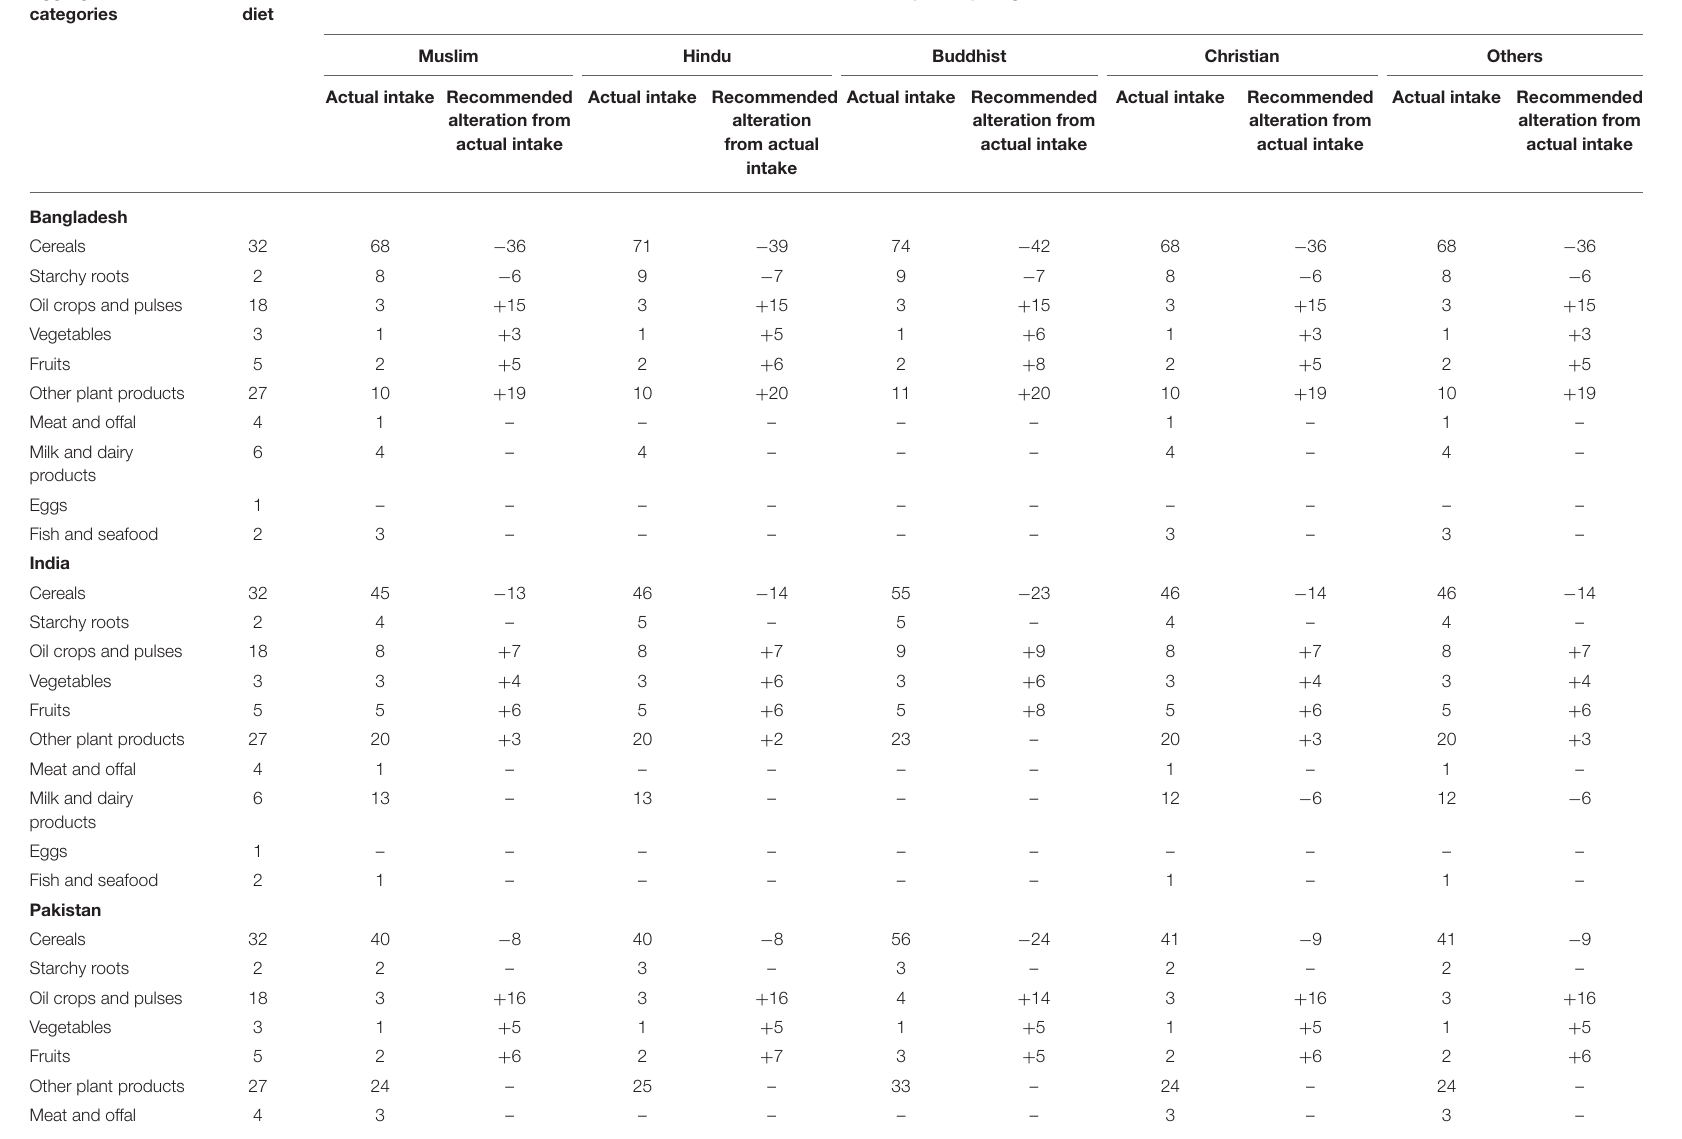
TABLE 2 | Recommended religion-sensitive alterations in food composition (% of food share) in EAT–Lancet planetary health diet based on FBSs in